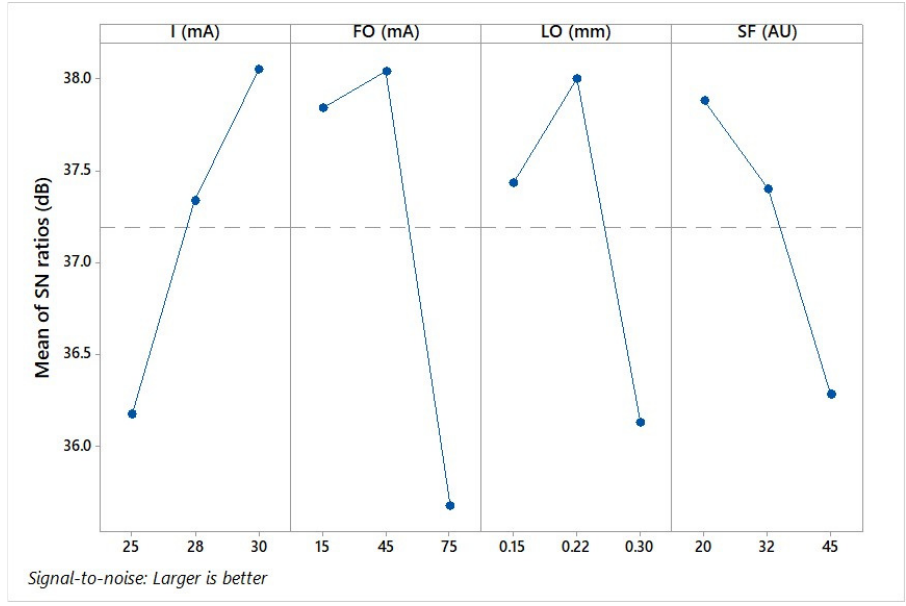
Figure 10. Main effect of each factor. Table 8. ANOVA